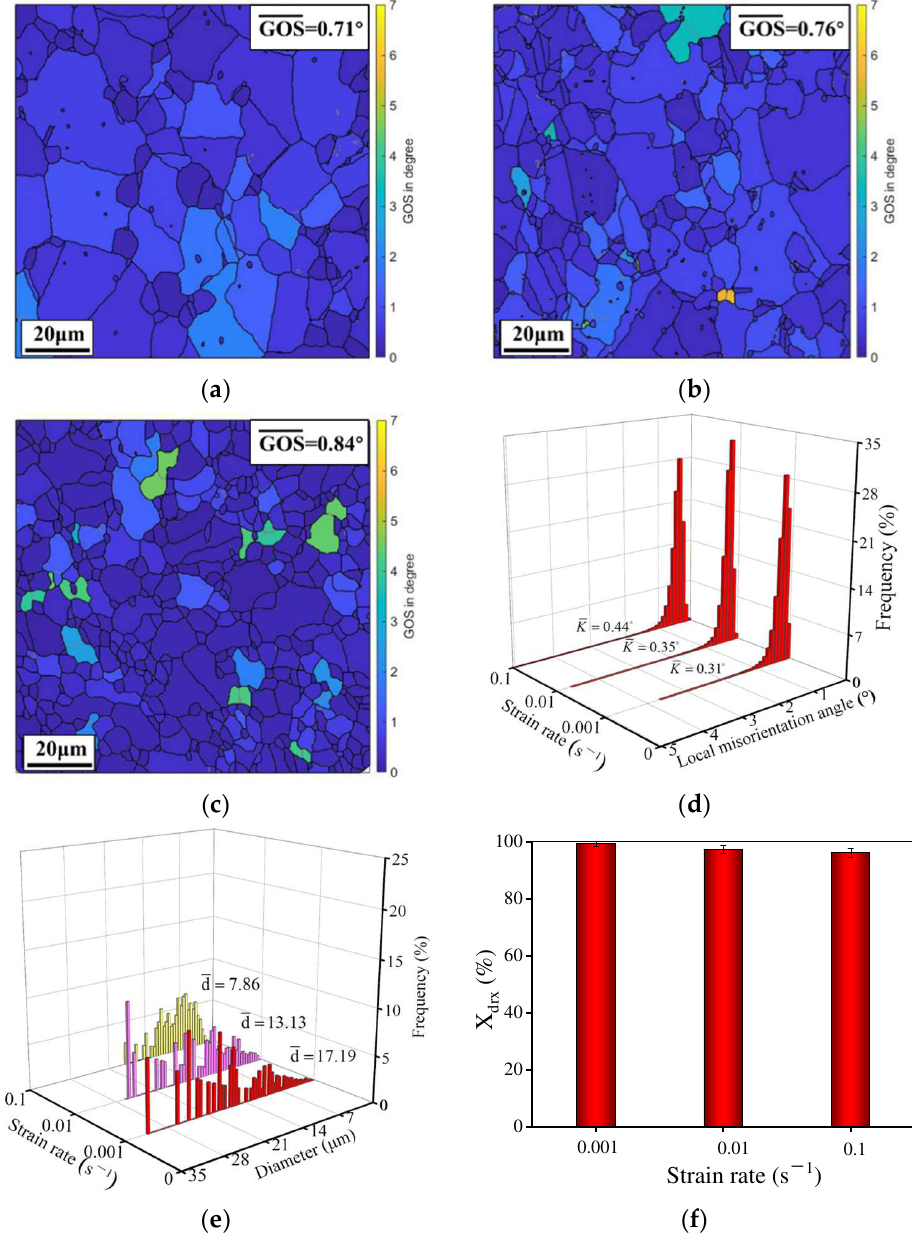
Figure 5. GOS maps of the HIPed superalloy deformed at a strain rate of ( a ) 0.001 s −1 ; ( b ) 0.01 s −1 ; ( c ) 0.1 s −1 [28]; ( d ) local misorientation angle; ( e ) average grain size distribution; ( f ) area fraction of DRX (the temperature and true strain are 1140 °C and 0.92, respectively).